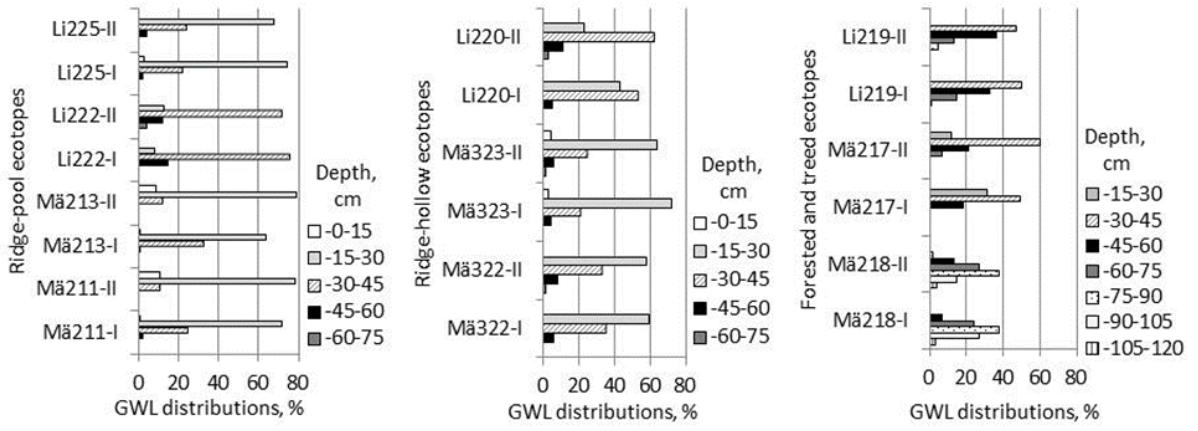
Figure A3. Frequency distribution (%) of the Period I and II groundwater levels (GWL) in different ecotopes of Linnusaare (Li) and Männikjärve (Mä) Bogs (see also Tables A1 and A2). A step of 15 cm depth is used for the GWL distribution